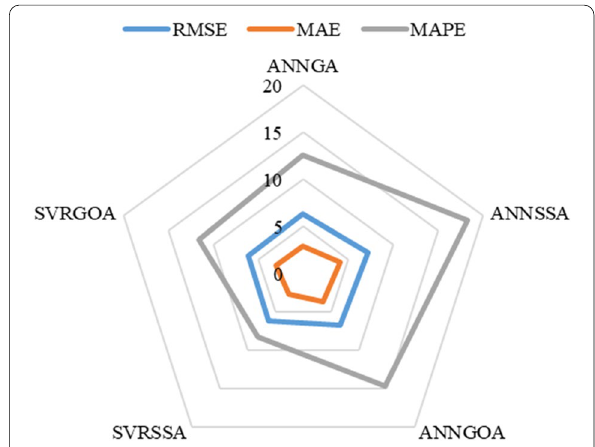
Fig. 13 A radar chart for comparing RMSE, MAE, and MAPE of the